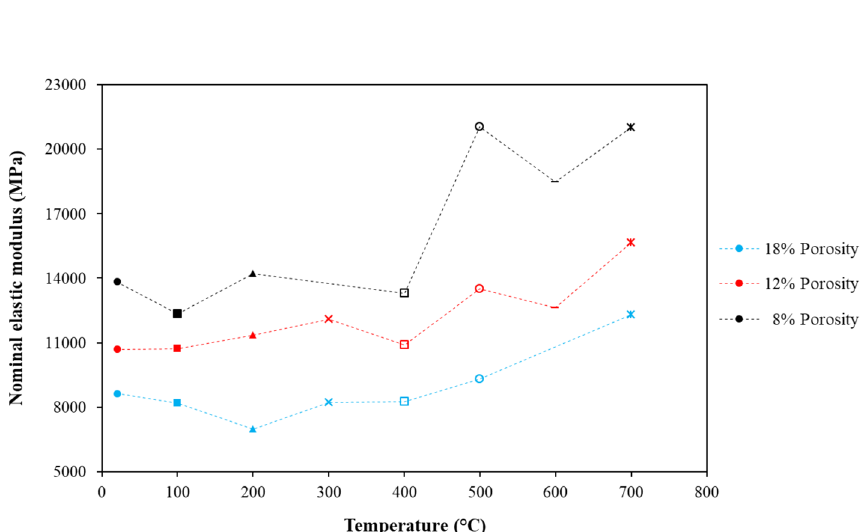
Fig. 7 Evolution of elastic modulus with rising tem- perature as derived from the corresponding tensile stress- strain curves for specimens containing various amounts of